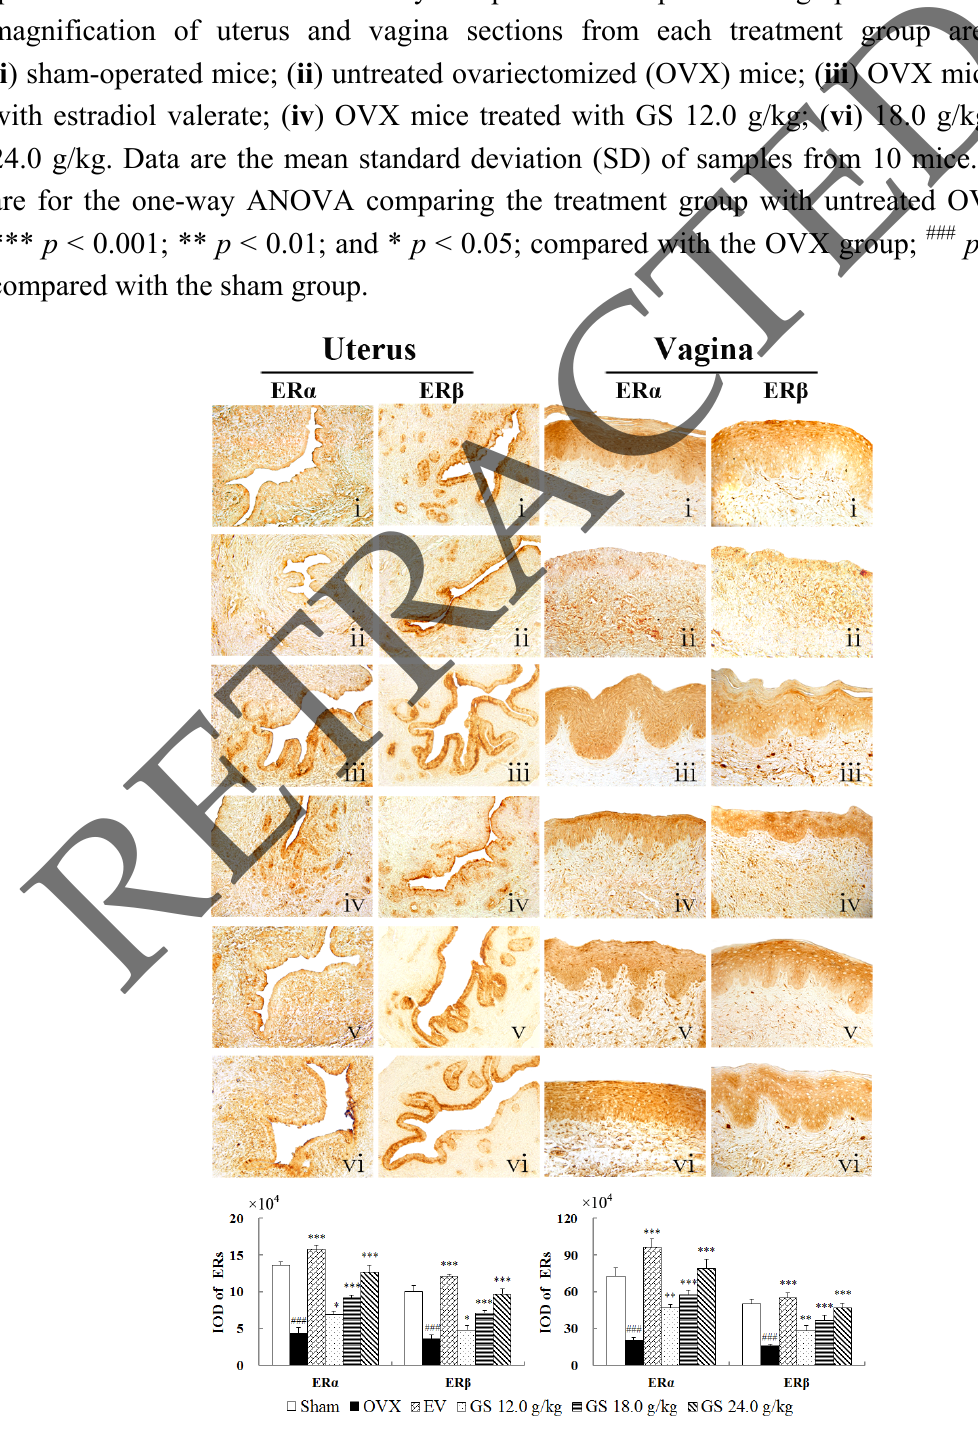
Figure 6. The effects of ginseng (GS) treatment on the expressions of estrogen receptor (ER) α and (ER) β in the uterus and vagina. ER α and ER β expressions were assessed